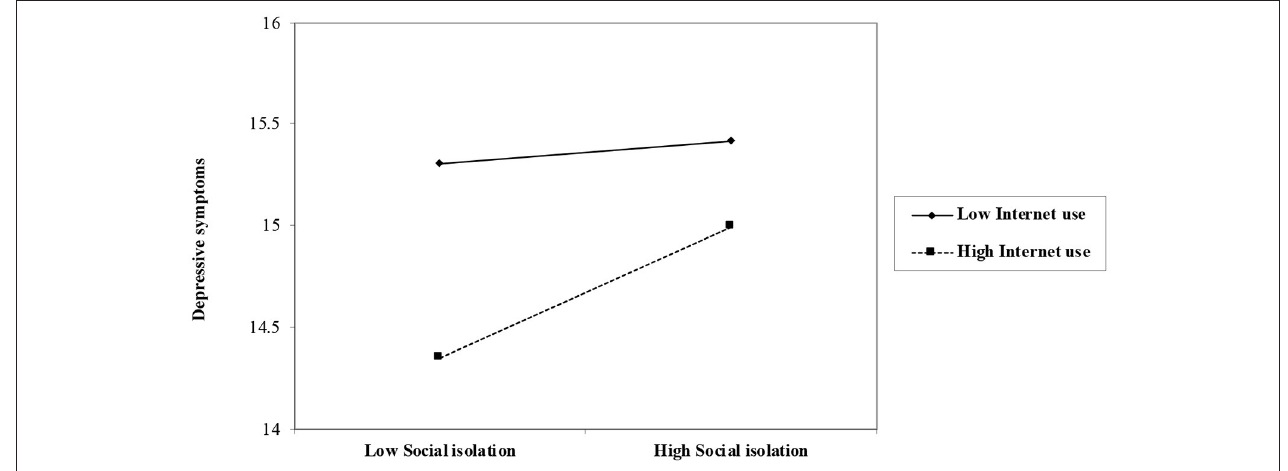
FIGURE 3 | Role of social isolation on depressive symptoms by levels of internet use among the entire sample ( N = 8,835).